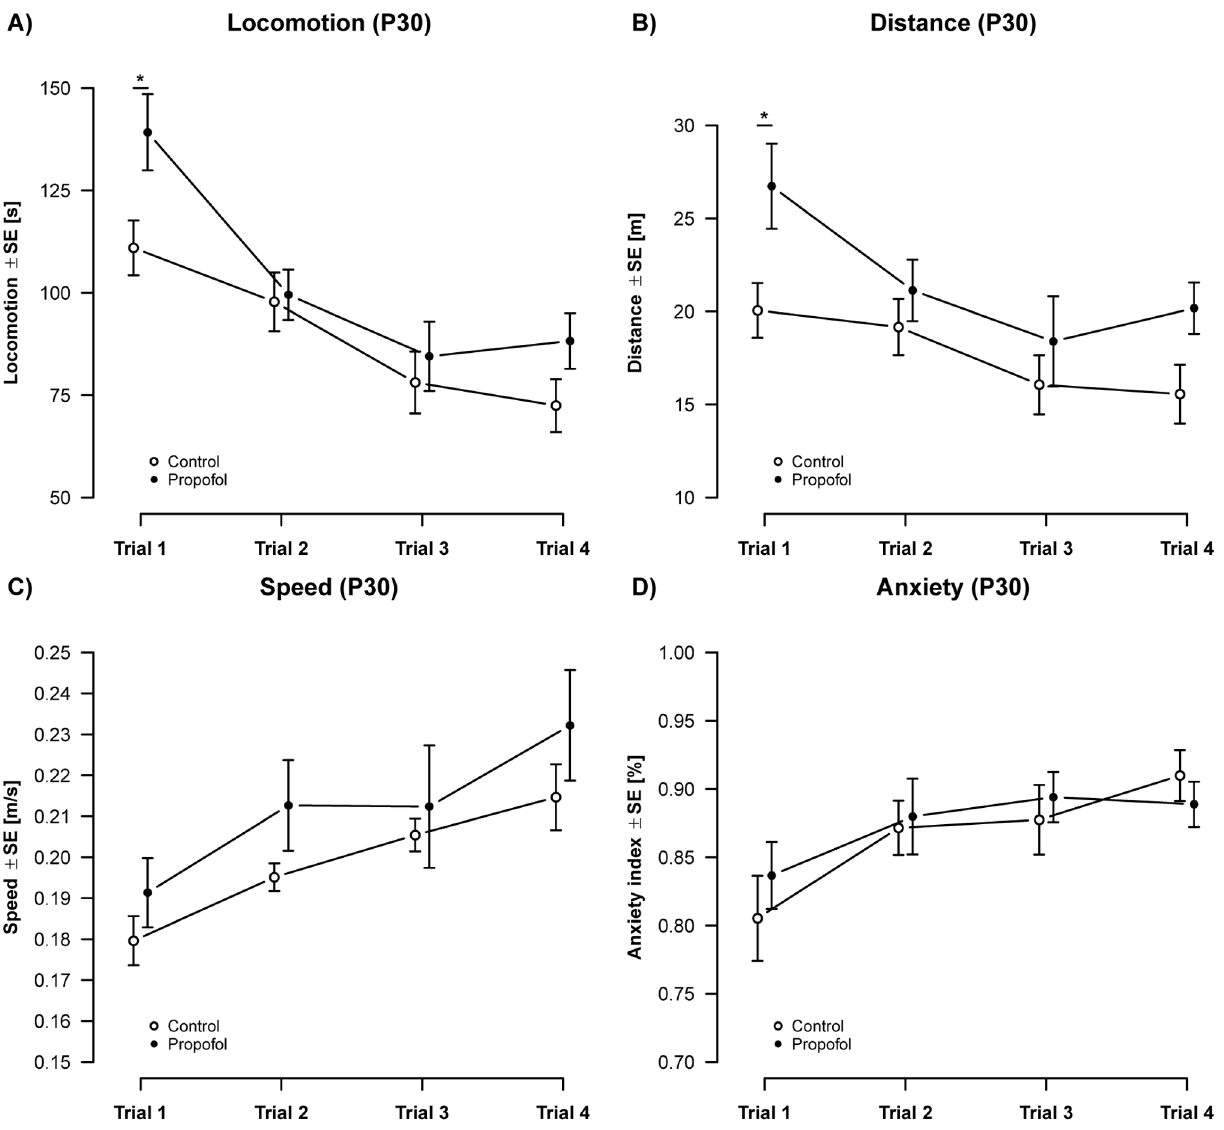
Figure 4. Activity (P30): Analysis of activity over 4 repeated measurements showed an overall increase in A) locomotion [F(1,71)=7.12, p=9 6 10 2 3 ] and B) distance [F(1,71)=7.36, p=8.37 6 10 2 3 ], but no change on C) speed [F(1,74)=1.92, p=1.69] in propofol treated animals. Propofol treatment did not alter D) anxiety related behavior in adolescent animals [F(1,74)=0.02, p=0.89]. An overall change in activity was observed over individual measurements, resulting in a significant decrease in locomotion [F(3,71)=13.6, p=4.08 6 10 2 7 ] and distance [F(3,71)=5.35, p=2.23 6 10 2 3 ] and a significant increase in speed [F(3,74)=15.7, p=5.53 6 10 2 8 ] and the index of anxiety [F(3,74)=7.25, p=3 6 10 2 4 ]. (n controls =12 animals, n propofol =8